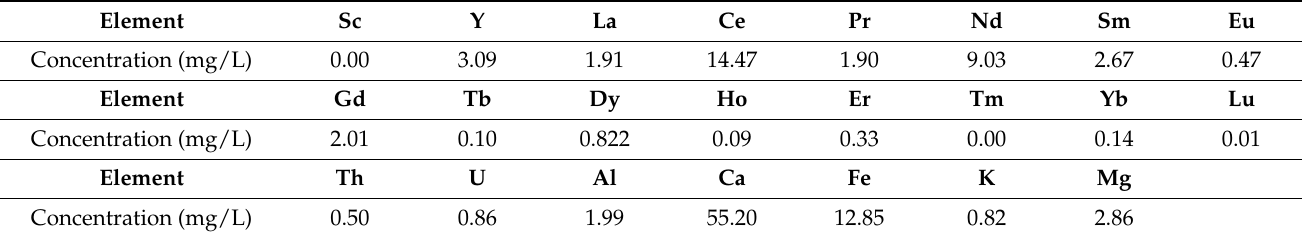
Table 1. Elemental composition of the synthetic